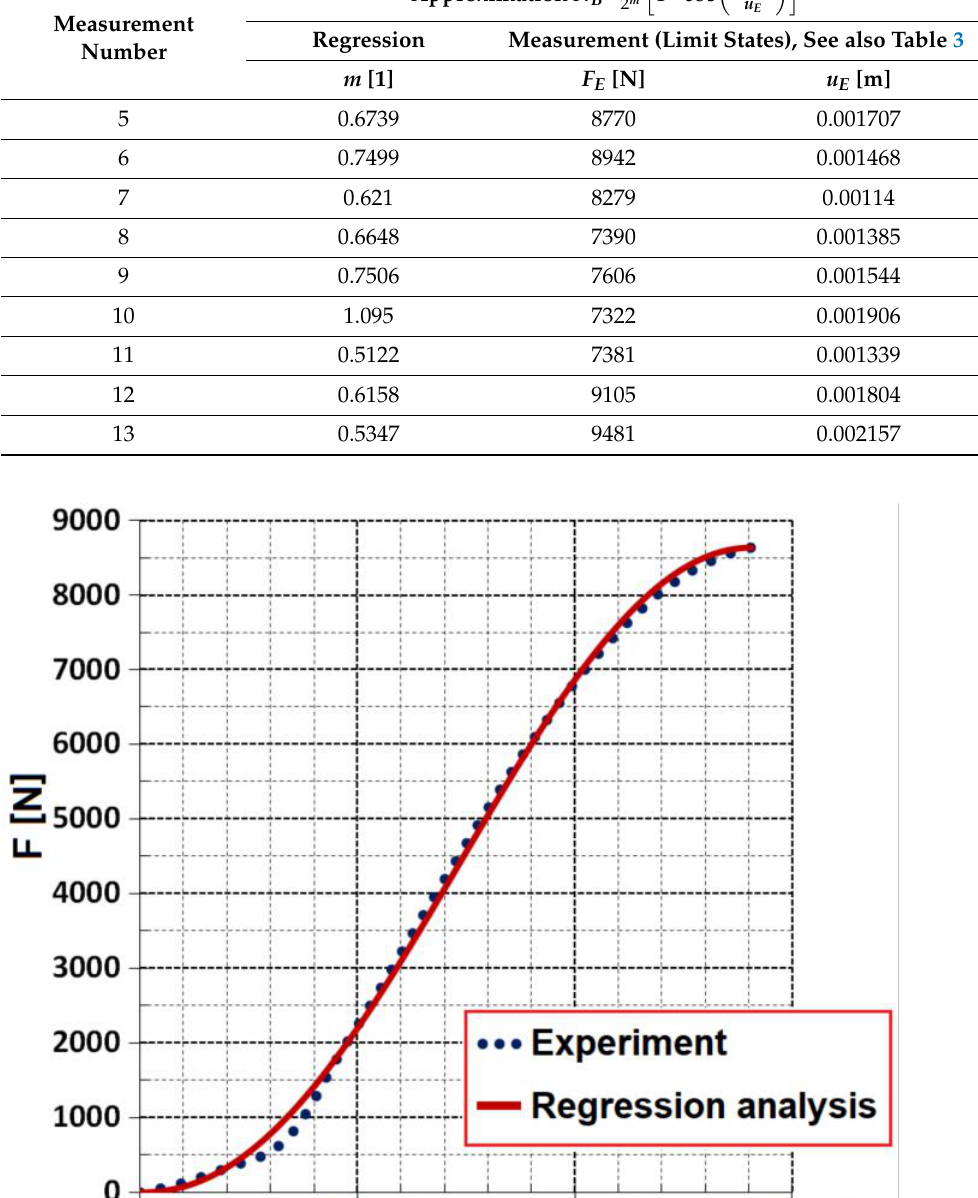
(cid:104) (cid:16) (cid:17)(cid:105) m π u B 1 − cos for u E 2 m